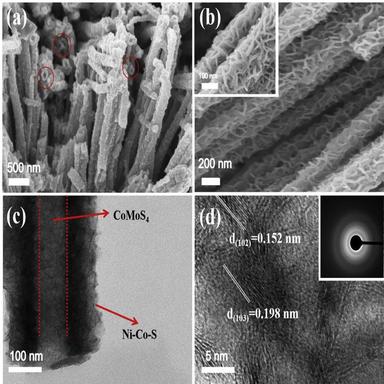
(a) Low and (b) high magnification SEM images of CMS-8 electrode; (c) TEM and (d) HRTEM image and the SAED patterns of the CMS-8 electrode.